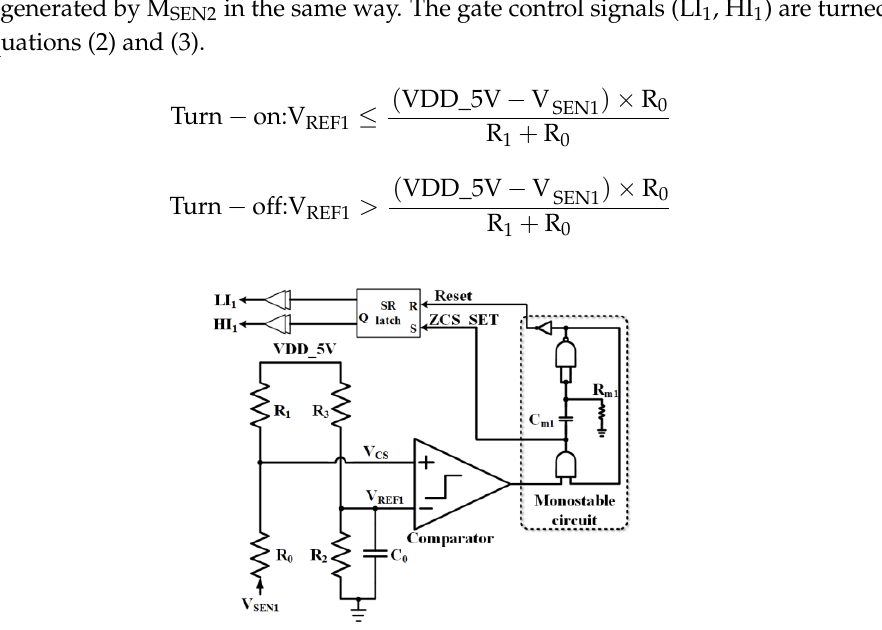
Figure 3. Zero current sensing (ZCS) circuit for M HS1 and M LS1 .